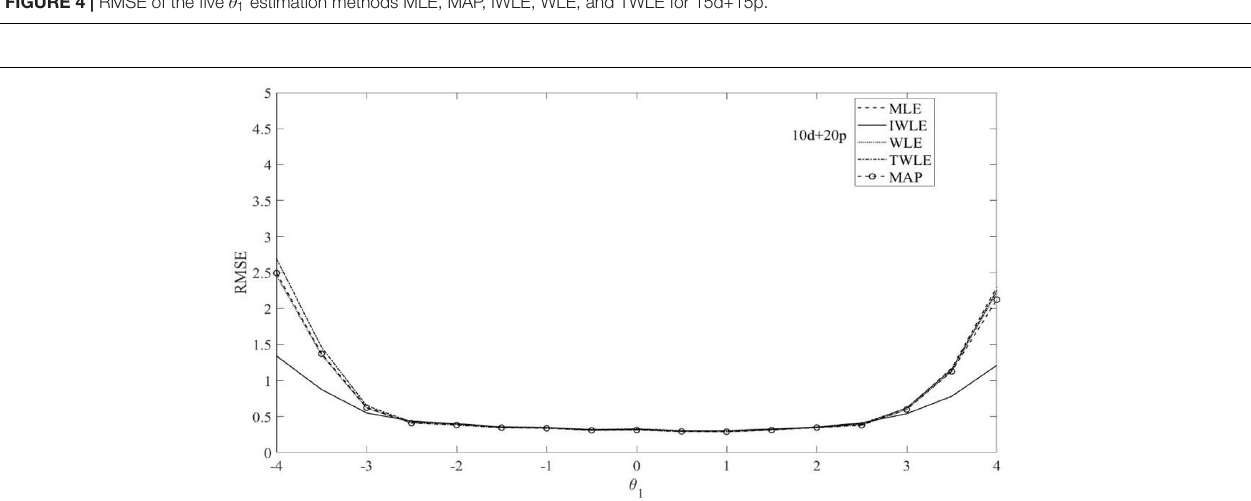
Frontiers in Psychology |